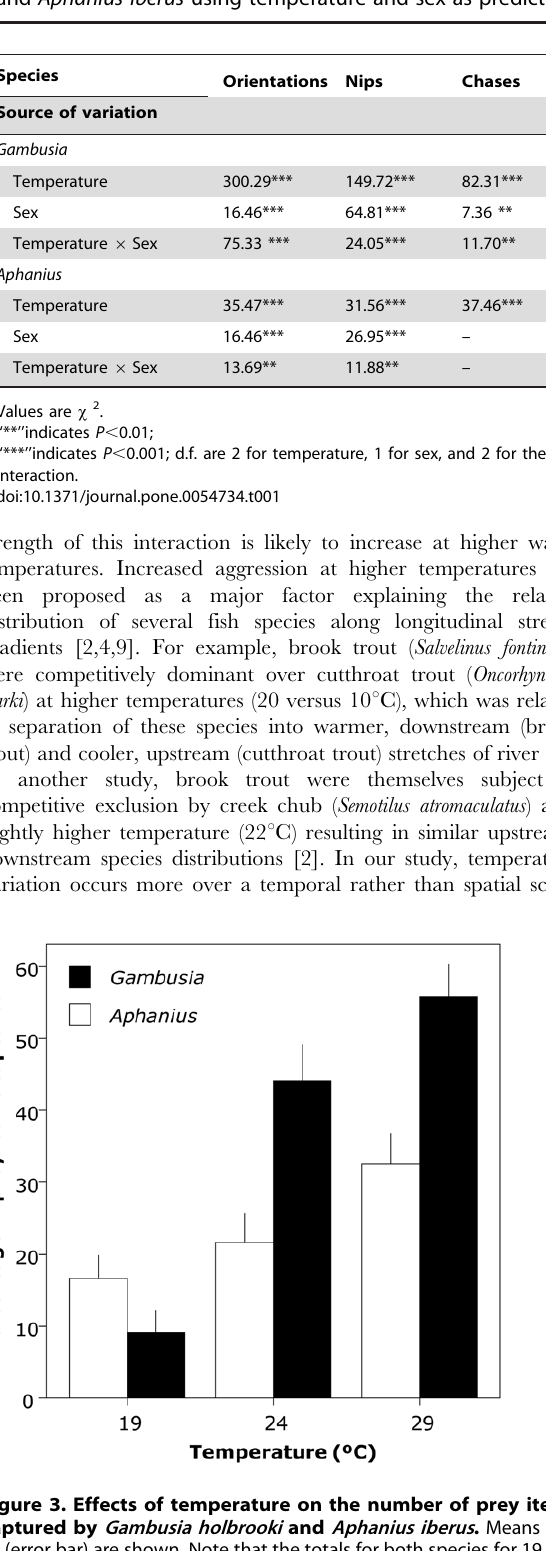
Table 1. Generalized linear models for selected response variables (i.e. orientations, nips, chases) of Gambusia holbrooki and Aphanius iberus using temperature and sex as predictors.